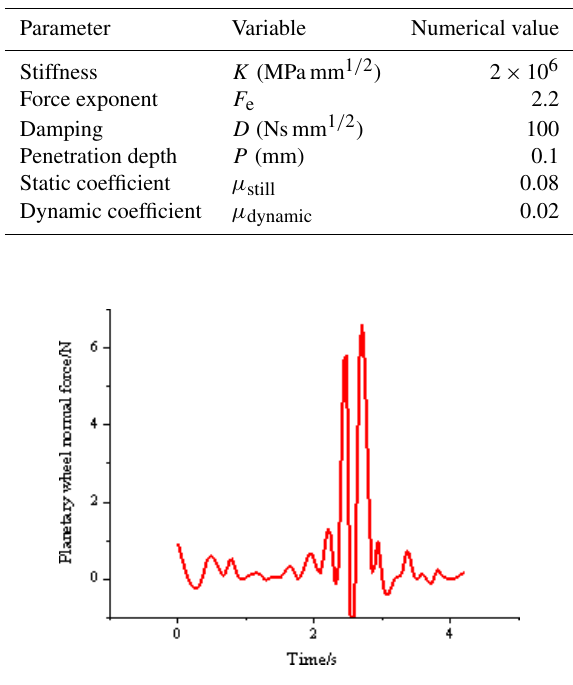
Figure 11. Sun gear circle force